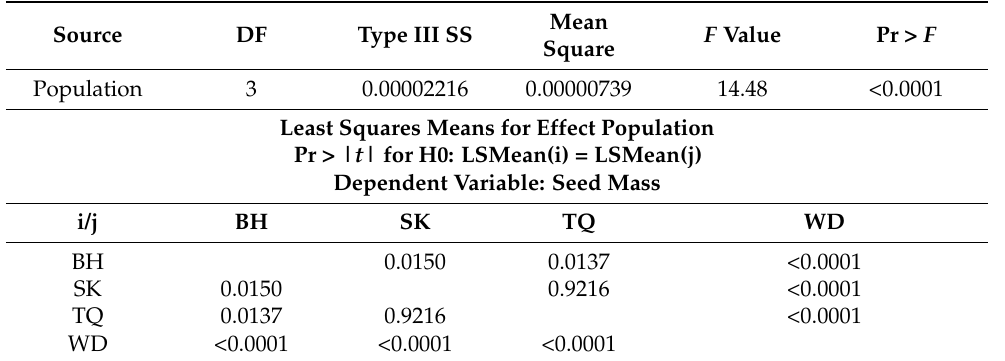
Table A9. 2019 Four Population Seed Mass.